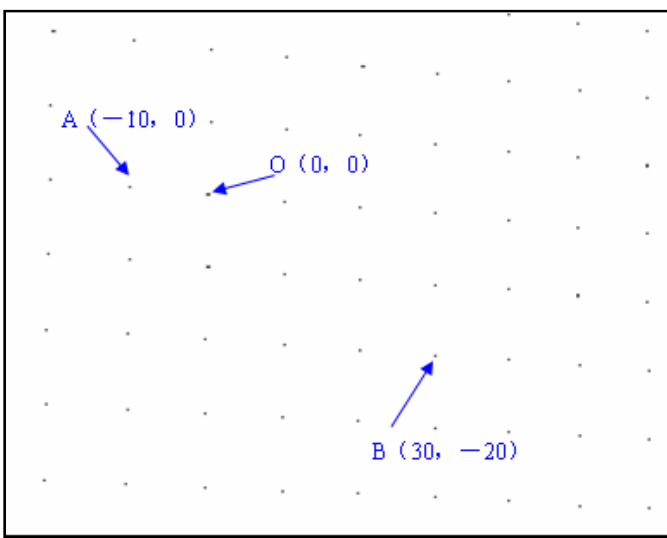
Figure 9. Center coordinates of black circles